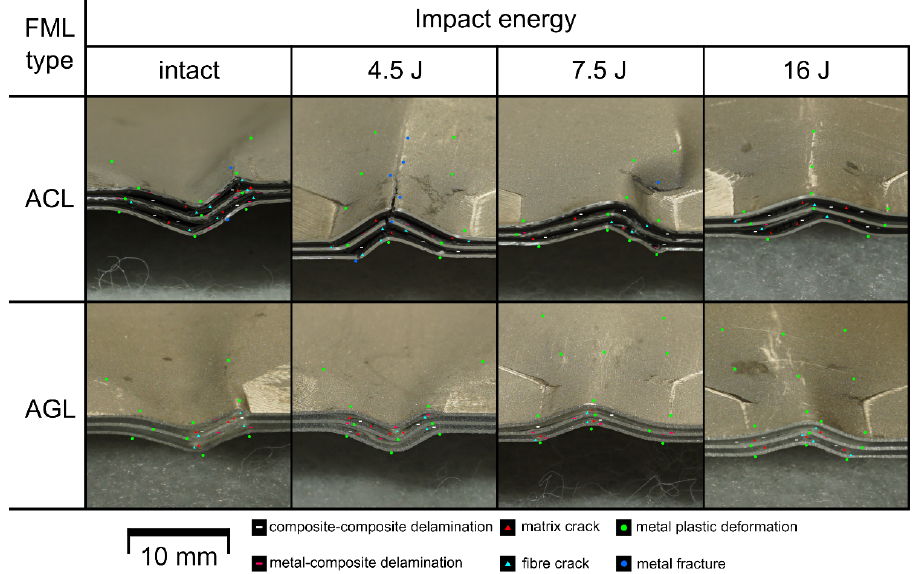
Figure 14. Detailed analysis of damage of FML after full CAI loading process.